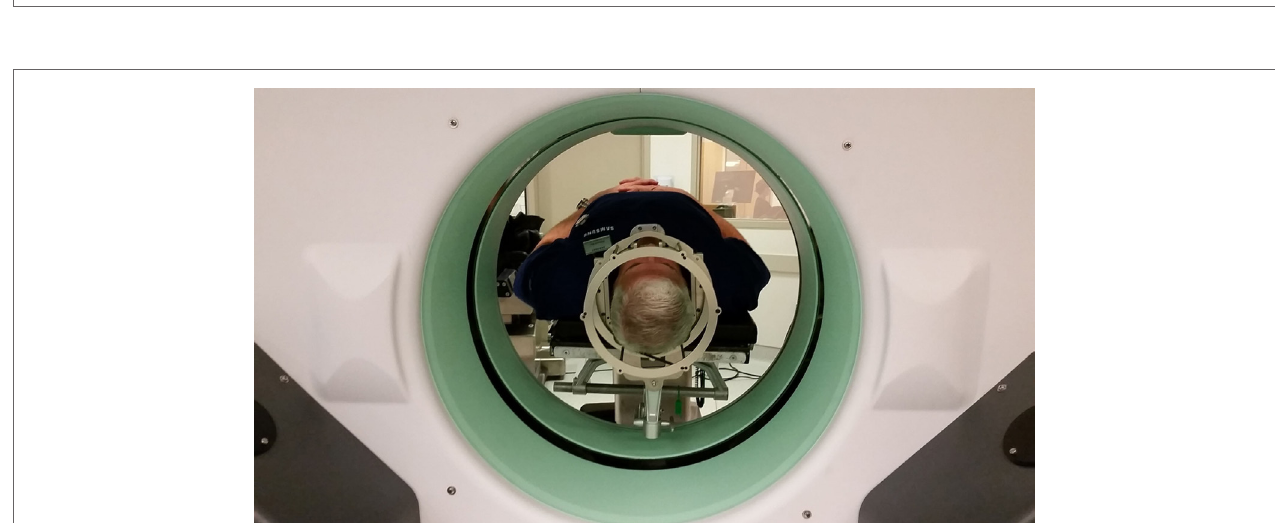
FIGURe 3 | simulation of intraoperative Ct scanning for image registration and DBs planning .